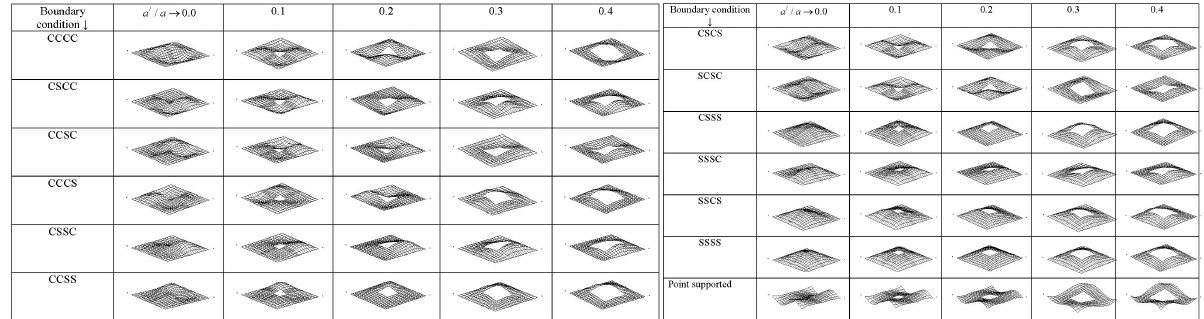
Figure 4: First mode shapes of laminated composite (0/90/0/90) stiffened elliptic parabolic shell for different sizes of the central square cutout and boundary